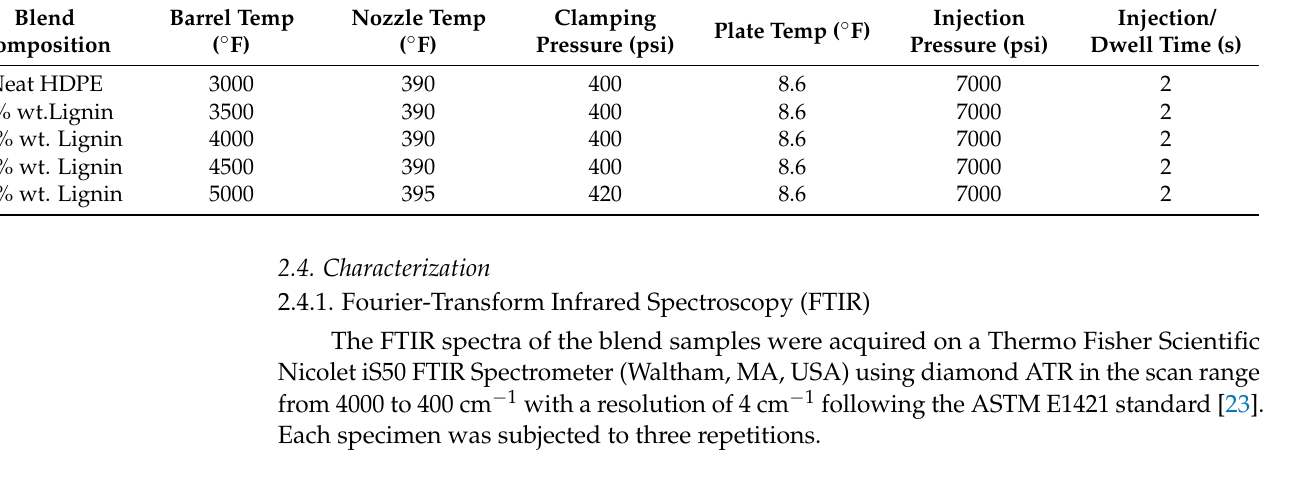
Table 2. Injection molding parameters for varying lignin